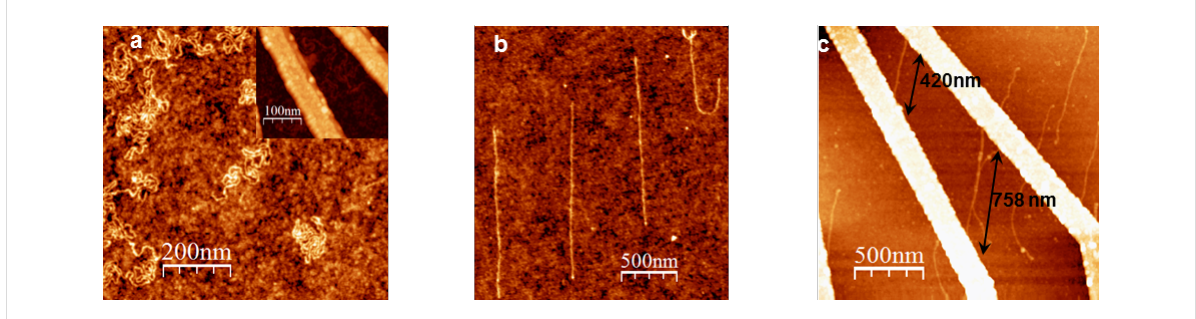
Figure 2: AFM topographic images of dsDNA molecules deposited on silicon substrates. (a) DNA deposited on APTMS-functionalized silicon substrates. The insert shows DNA in the area with nanoelectrodes. (b) DNA molecules combed on hydrophobically modified silicon substrates by using the proposed variation of the combing method. (c) DNA combed across nanofabricated electrodes. The typical observed dsDNA height was 0.7 ± 0.2 nm, in line with other experiments.